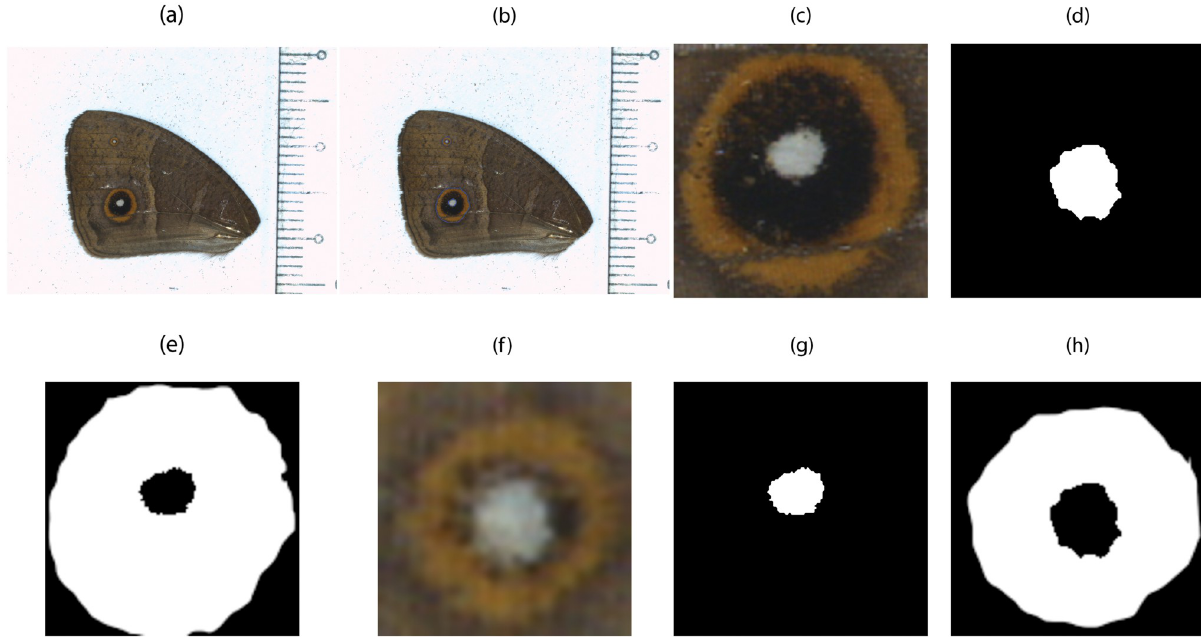
Fig 2. Illustration of ground truth created for Bicyclus anynana wing image, where white regions correspond to areas we wish to measure and for which we also have obtained manual measurements. ( a ) The original RGB image with two marginal eyespots. ( b ) Image with ground truth circles superimposed on each eyespot. ( c ) Large eyespot crop resized to 128x128 pixels. ( d ) Large eyespot center ground truth mask. ( e ) Large eyespot rings ground truth mask. ( f ) Small eyespot crop resized to 128x128 pixels. ( g ) Small eyespot center ground truth mask. ( h ) Small eyespot rings ground truth mask.